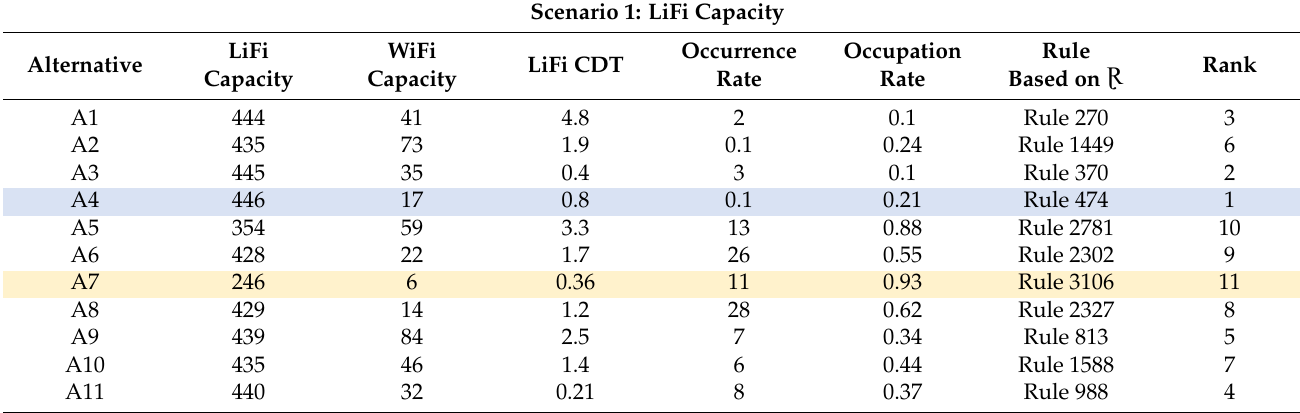
Table 9. Using Criteria #1 (LiFi capacity) for ranking the best and worst alternatives.